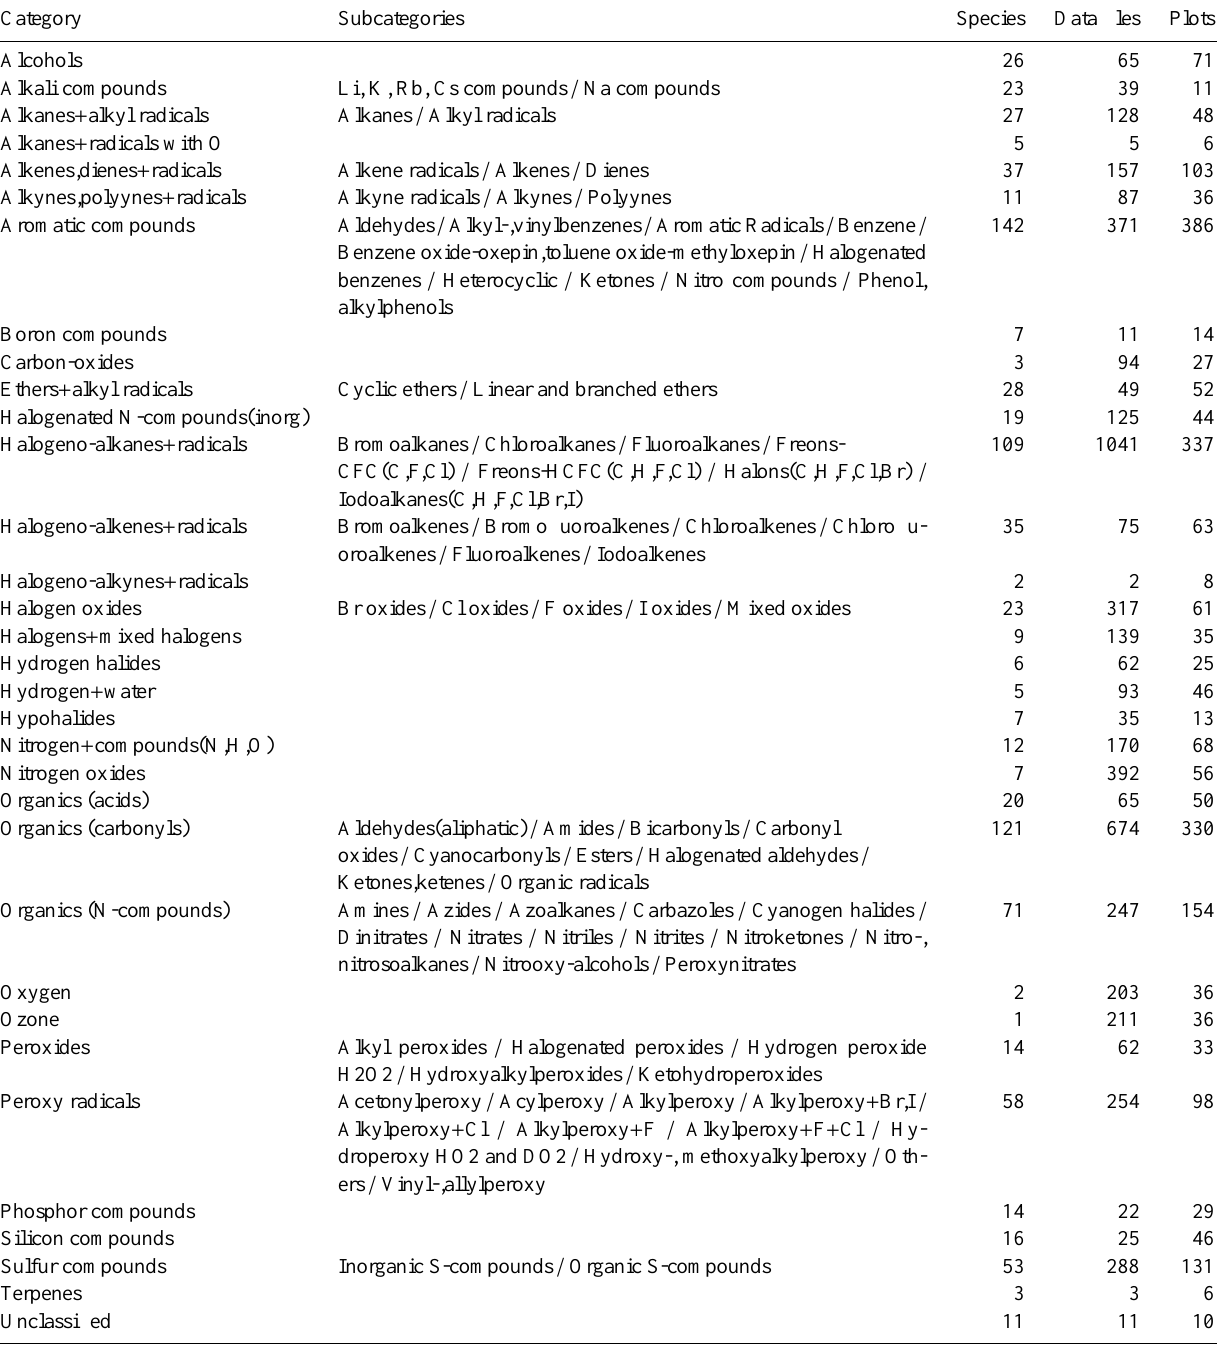
Table 1. Classification of the species into categories and